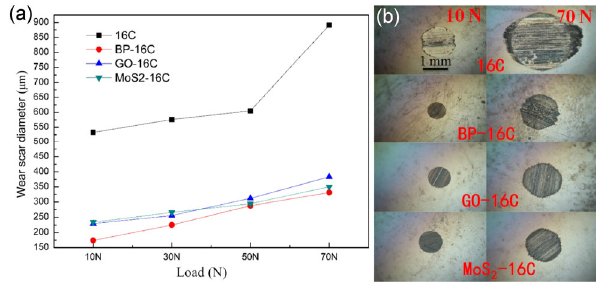
Fig. 12 Wear properties of upper samples (ball): (a) wear scar diameter of balls; (b)